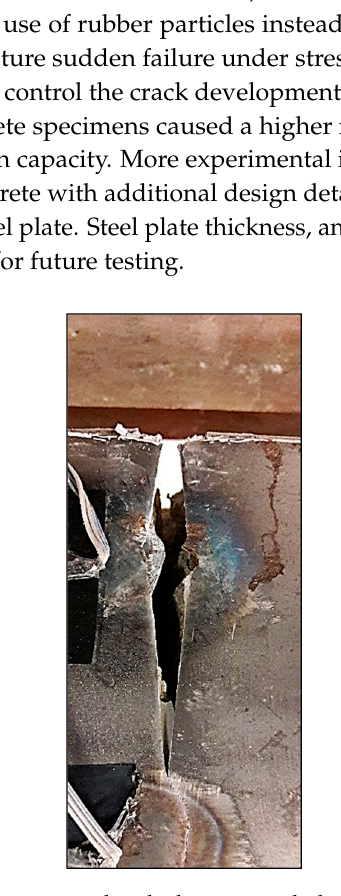
Figure 12. Steel rupture occurred at the bottom steel plate of the CC-W specimen.